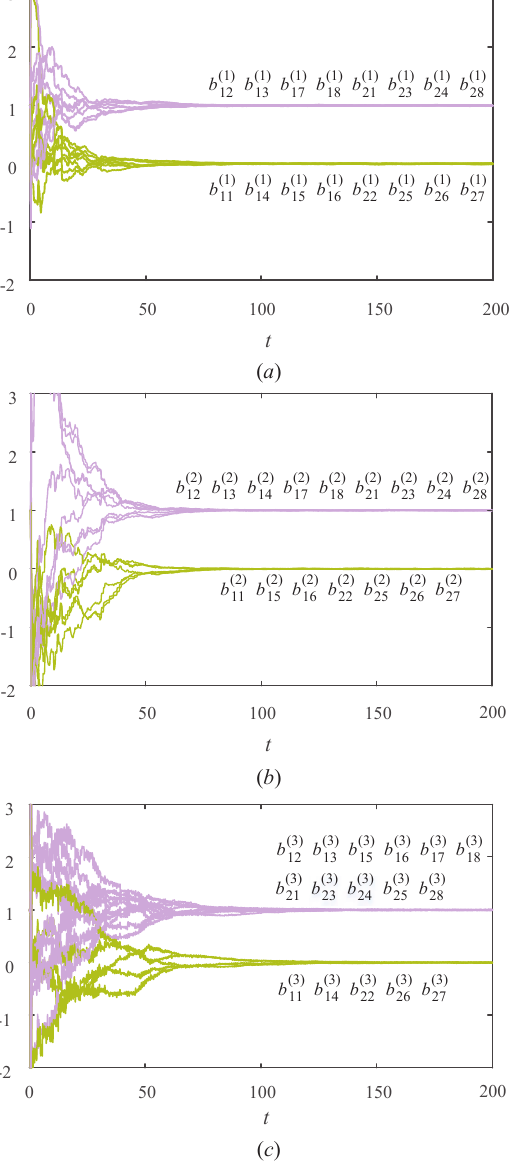
Figure 5. The identification of coupling configuration matrices ¯ A ( i ) ( i = 1,2,3 )